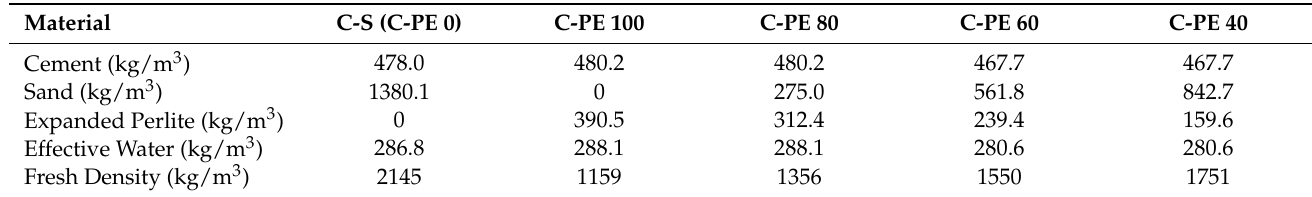
Table 2. Mix proportions of cement mixes in SSD condition.